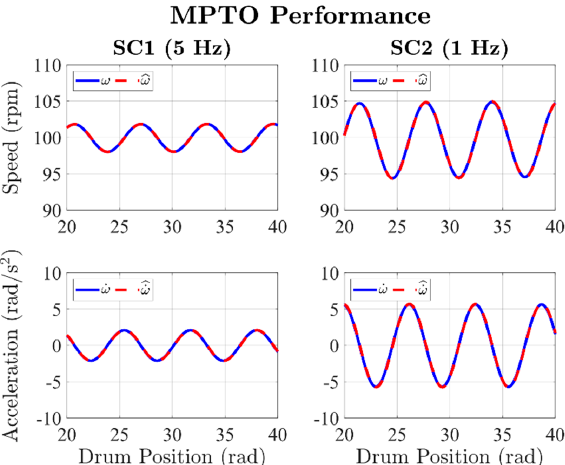
Figure 15. Speed- and acceleration-tracking performance of the MPTO.